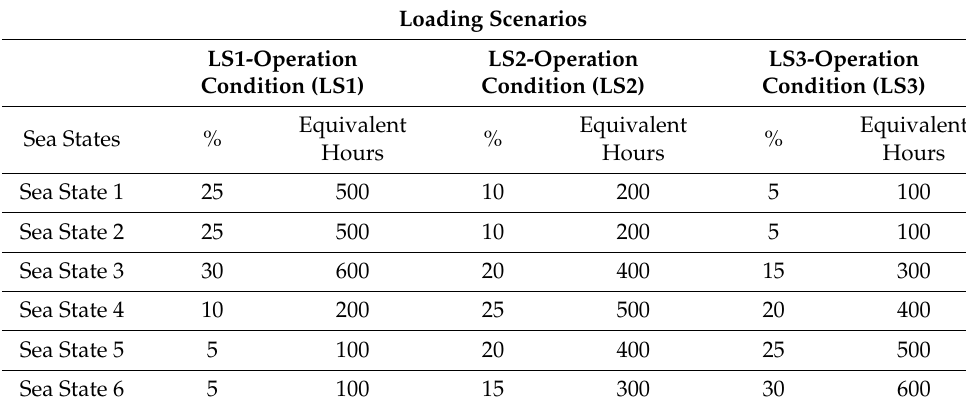
Table 2. Possible loading scenarios and operation